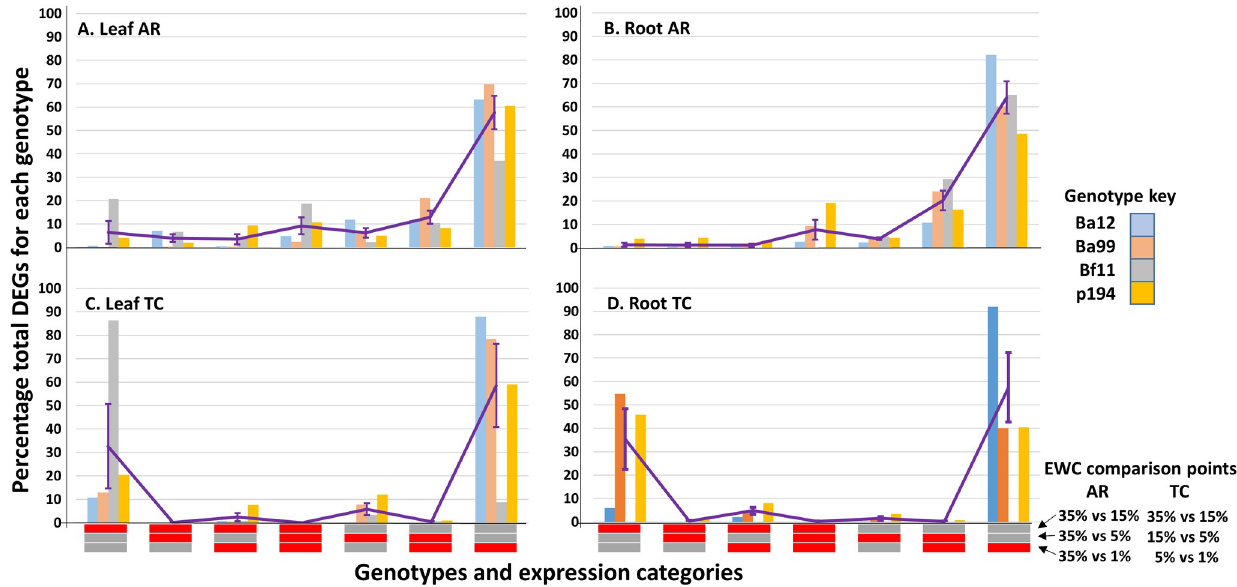
Fig 2. Relative proportions of differentially expressed genes (DEGs) across genotypes and expression categories. A. leaf against reference (AR); B. root AR; C. leaf time course (TC); D. root TC. For the root TC DEGs, Bf11 has been omitted as only 20 DEGs of any kind were present in this class. The purple line connects the average proportion of DEGs across genotypes for each expression category. Error bars indicates standard errors. The expression categories are indicated as horizontal bars beneath the x axis where red means genes differentially expressed and grey not differentially expressed for that component of the expression category, respectively. Estimated growing medium water contents (EWC) associated with the expression category components are given at the end of the x axis.